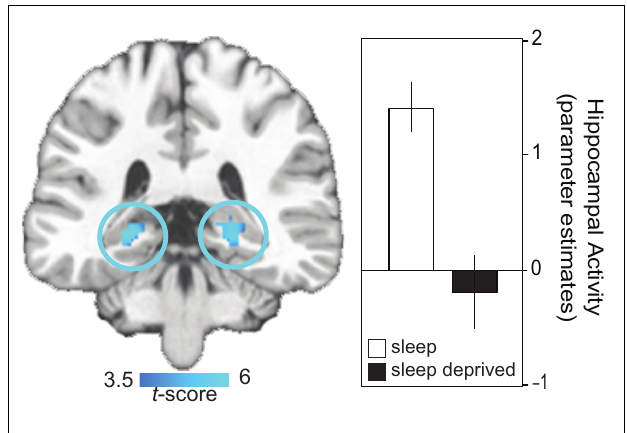
FIGURE 1 | Neural basis of sleep-deprivation induced encoding deficits. Regions of decreased encoding activation in the sleep deprivation group relative to the sleep control group in bilateral posterior hippocampus, together with a histogram of parameter estimates (effect size) of averaged hippocampal activity in each group. Effects are significant at p < 0.001; > 5 contiguous voxels. Modified fromYoo et al.